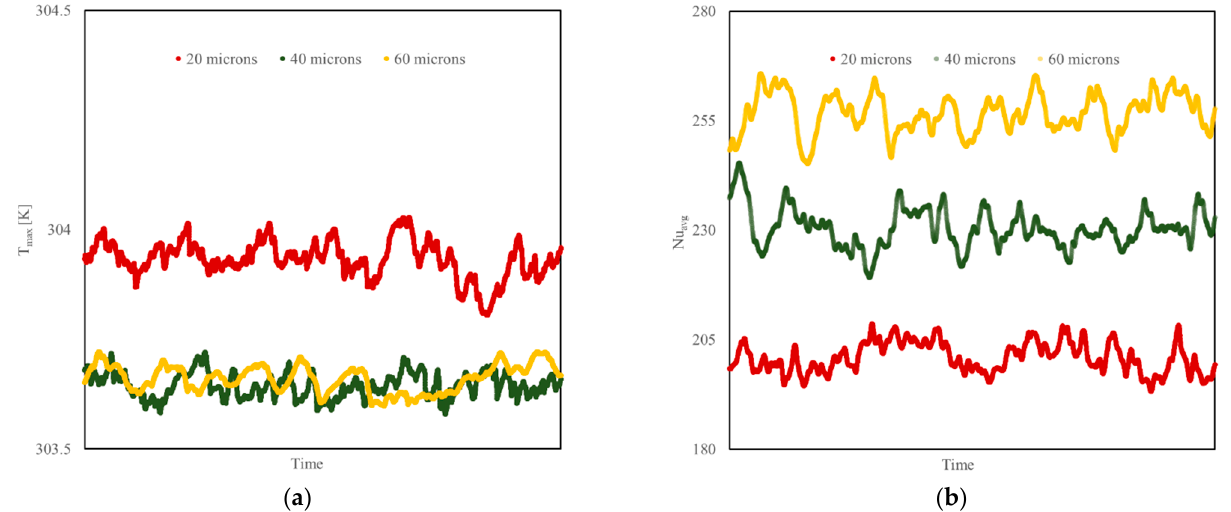
Figure 11. Actual thermal performance: ( a ) maximum facet temperature on the rough surface, and ( b ) averaged heat transfer coefficient on the rough surface.